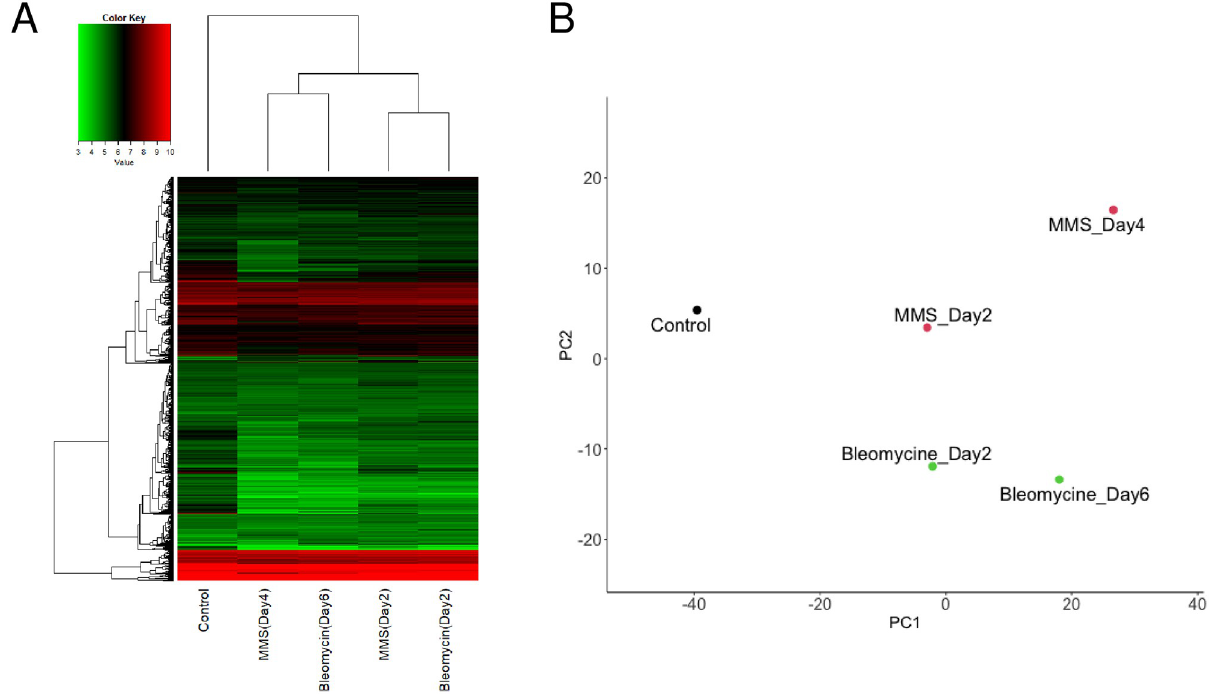
Fig 3. Interrelationships between expression profiles of lenses with MMS or Bleomycin-induced opacity. (A) Heatmap showing the relationship between gene expression profiles of Control, MMS Day 2, MMS Day 4, Bleomycin Day 2, and Bleomycin Day 6 groups. In the vertical direction, 4,649 genes remained after outliers (probes without a corresponding gene name and probes with signal values < 5) were excluded. Genes with decreased signal values are shown in green, and genes with increased signal values are shown in red. The clustering at the top indicates the similarity between samples, and the lower the clustering hierarchy, the higher the similarity between clusters. (B) A PCA plot showing the relationship between gene expression profiles of Control, MMS Day 2, MMS Day 4, Bleomycin Day 2, and Bleomycin Day 6 groups. The signal values of 4,649 genes, the same as in (A), were used to generate the PCA map. A closer distance between the sample dots indicates a higher degree of similarity between gene expression profiles.